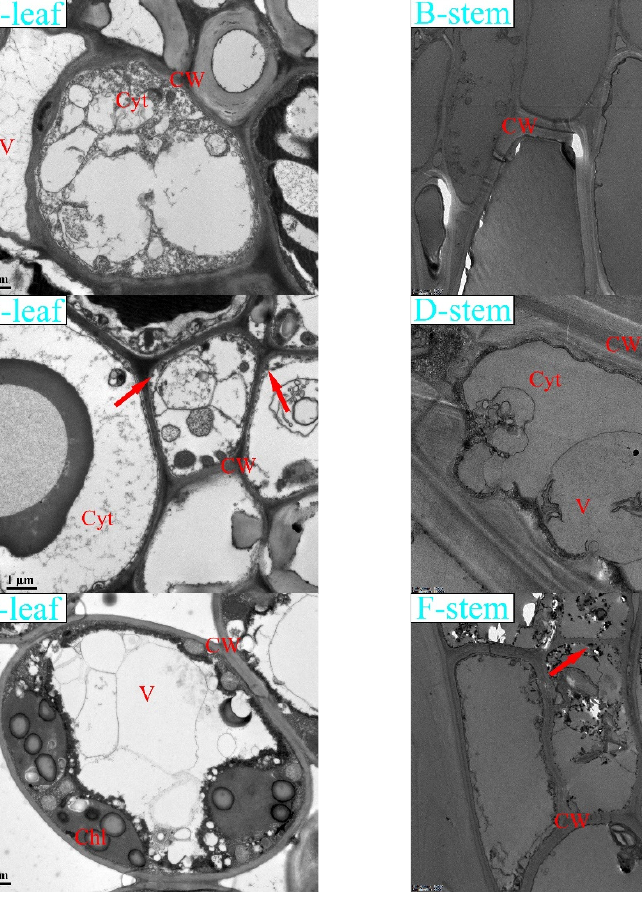
Figure 4. The effects of Pb stress on plant microstructure. Note: Pictures of root, stem, and leaf cells of K. paniculata seedlings in four treatments taken by TEM, CK treatment group, B treatment group (400 mg·L − 1 ), D treatment group (800 mg·L − 1 ), and F treatment group (1200 mg·L − 1 ). CW: cell wall; SG: starch granules; Cyt: cytoplasm; V: vacuoles; Chl: chloroplast.